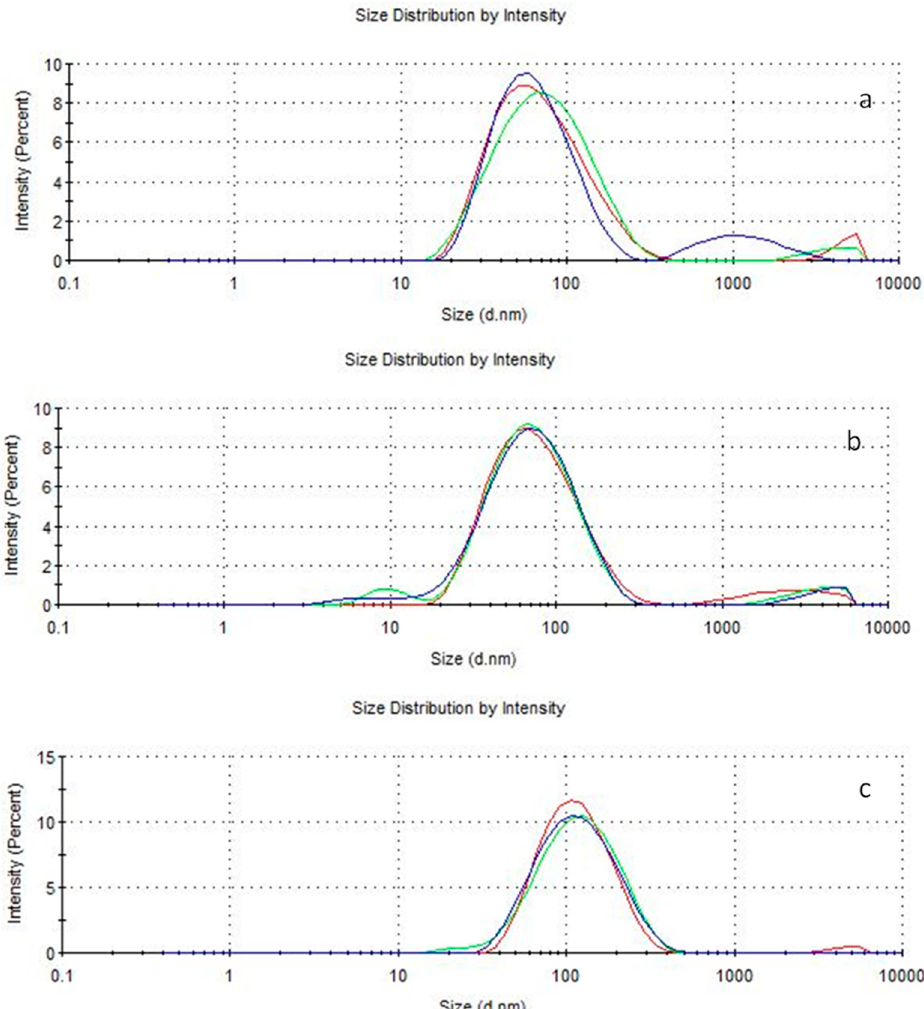
Figure 5. Particle size distribution of empty ( a ), BEO-loaded Nps ( b ), OEO-loaded Nps ( c ) after one week storage at 4 °C.